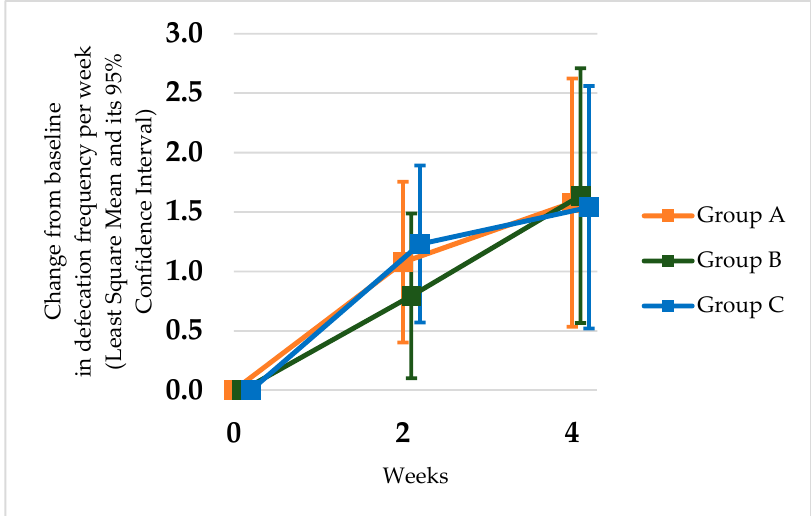
Figure 1. Change from baseline in defecation frequency in the groups administered Lactobacillus reuteri DSM 17938 (group A), combination (group B), and magnesium oxide (group C). Time course of the comparison of the differences in the defecation frequency after the initiation of the treatment. All three groups showed a significantly increased defecation frequency at weeks 2 and 4 compared with the baseline.